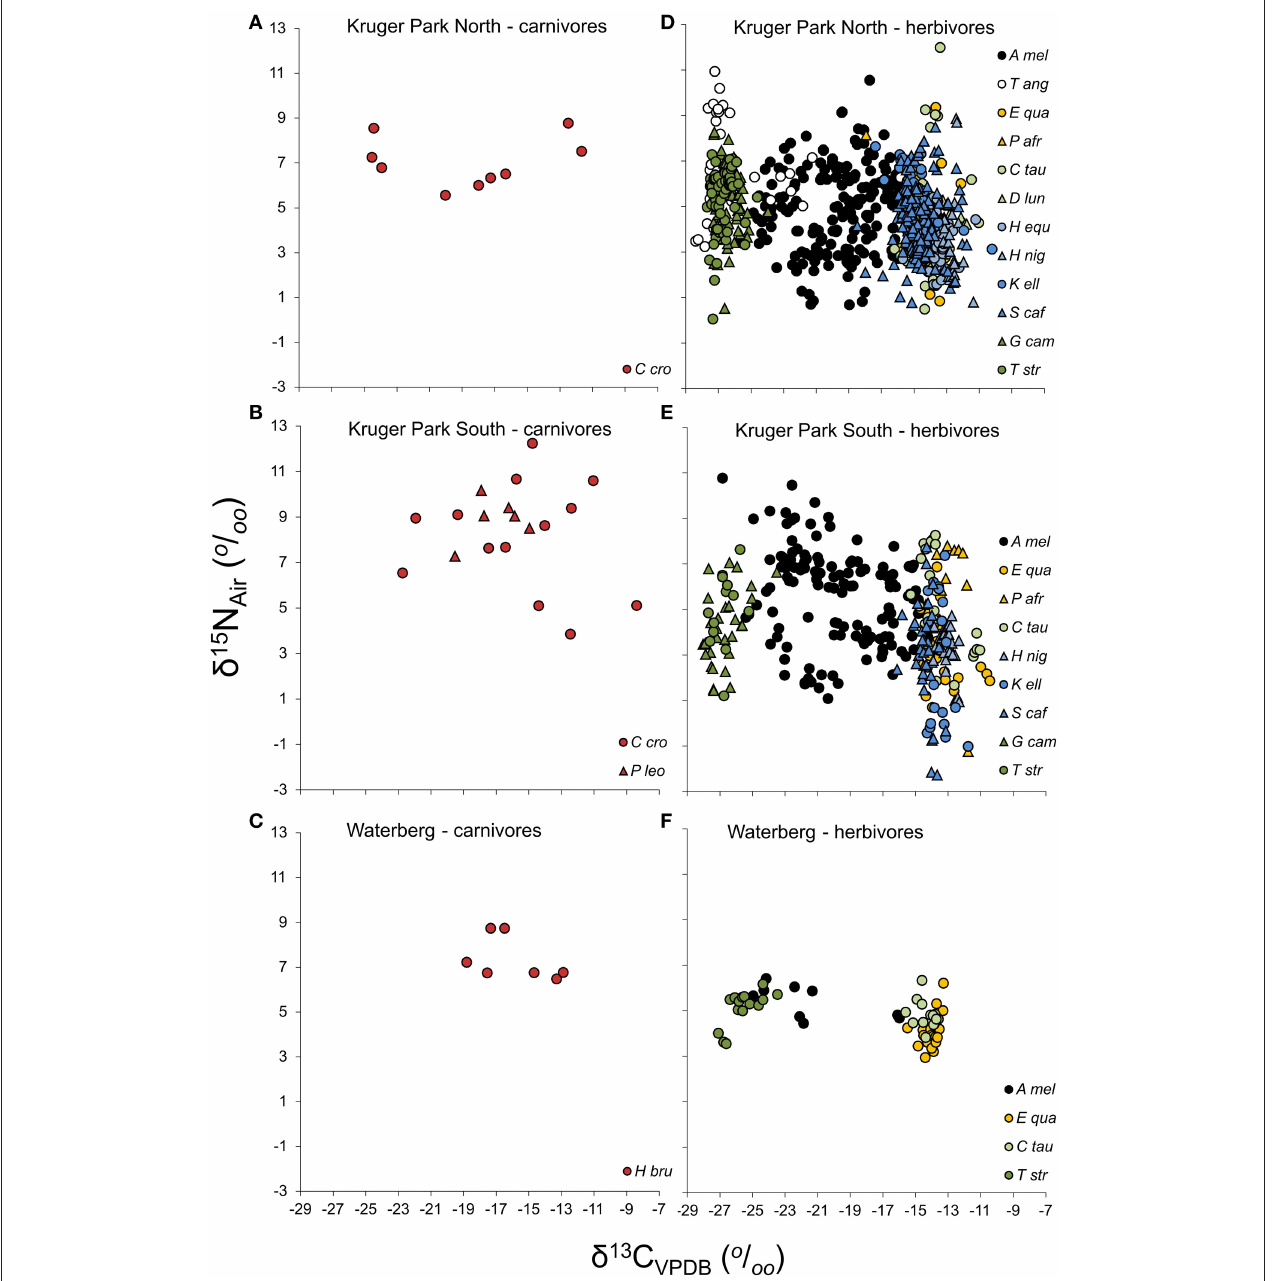
FIGURE 2 | Stable carbon and nitrogen isotope values of carnivore (A–C) and herbivore (D–F) feces from Kruger Park and Welgevonden Private Game Reserve in the Waterberg. See Table 1 for full species names.